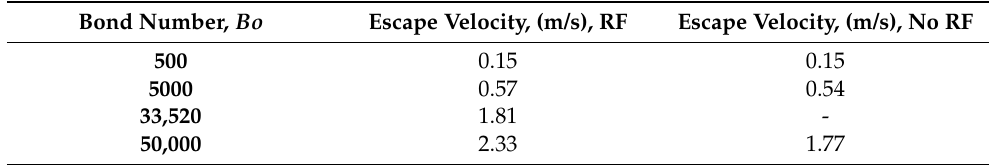
Table 3. Escape velocity as a function of Bond number with (RF) and without (no RF) rolling friction. Bond Number,